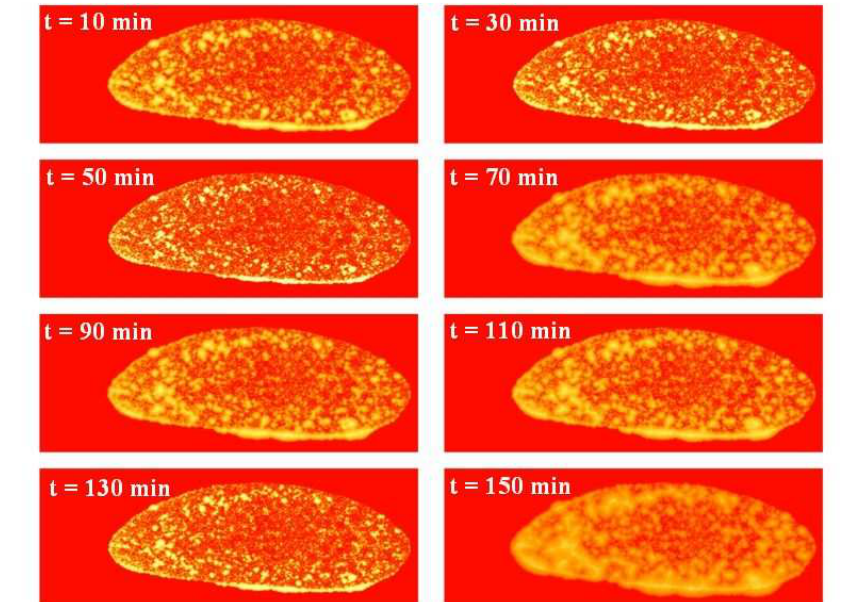
Figure 11: Bicoid spatio-temporal dynamics simulated with Fick’s law with constant diffusion coefficient equal to 0.3 µ m 2 s − 1 . The kinetics results to be much slower than the observed one and it no shuttling movement of bicoid in and out the nuclei are reproduced in the time interval from 10 to 150